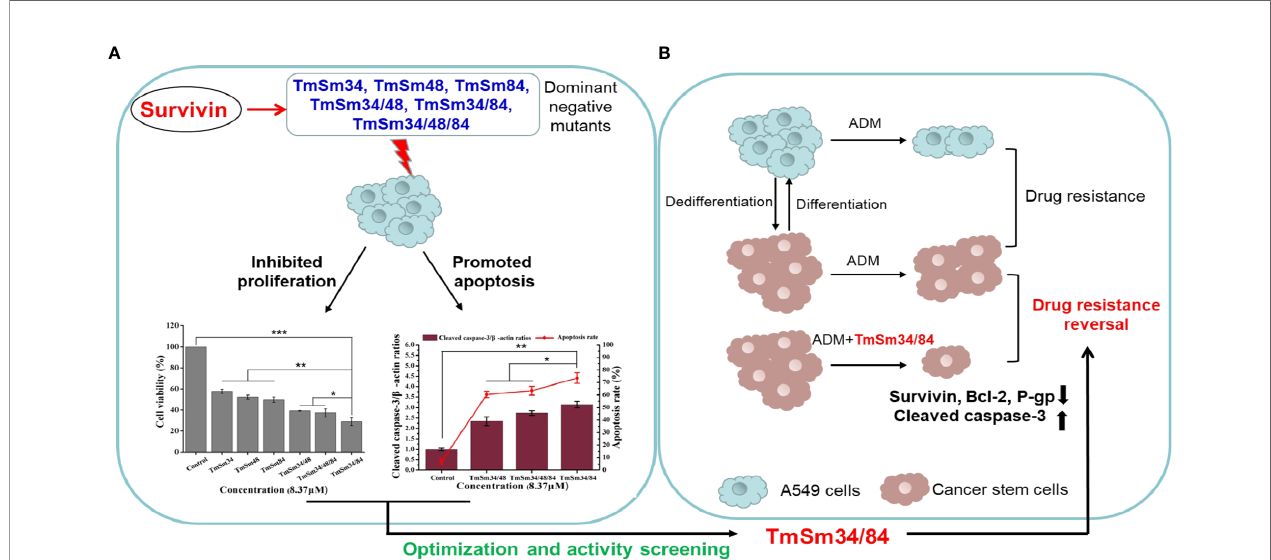
FIGURE 1 | Systematical diagram of design idea and researching fl ow of discovering a dominant negative mutant derived from survivin with stronger pro-apoptotic activity to cancer. (A) Compared with TmSm34, TmSm48, TmSm84, TmSm34/48, and TmSm34/48/84, TmSm34/84 had the strongest capacity in inhibiting proliferation and promoting apoptosis of A549 cells. (B) TmSm34/84 could reverse the drug resistance of A549 CSCs to Adriamycin (ADM) by down-regulating survivin, Bcl-2, and P-gp expression, while up-regulating cleaved caspase-3